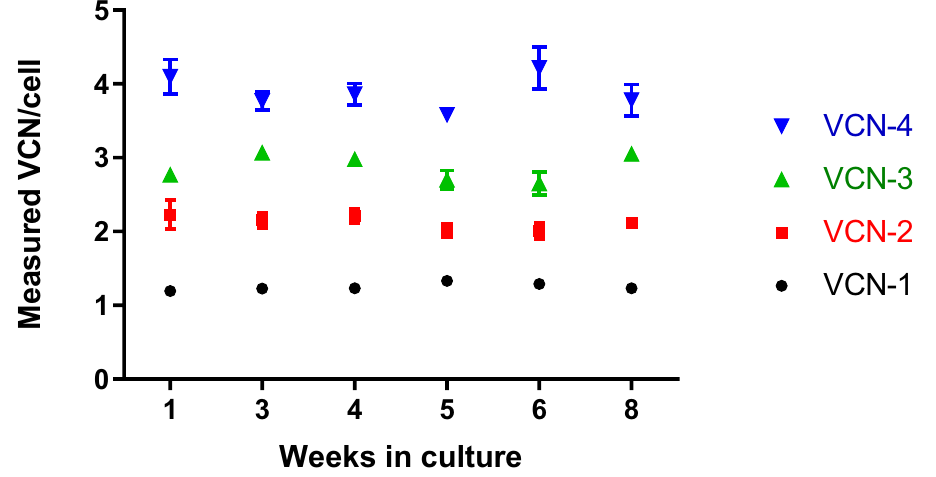
Figure 5. VCN reference standards stability in cell culture. Established VCN standard cell lines were cultured for 8 weeks using suspension cell culture conditions specific for Jurkat cells. Each week cell pellets were collected to evaluate VCN stability in culture. Genomic DNA was extracted from collected cell pellets and VCN per cell was measured using the GAG duplex qPCR assay. No VCN change was observed during 8 weeks propagation time in culture. Error bars represent standard deviations for the means of replicates.